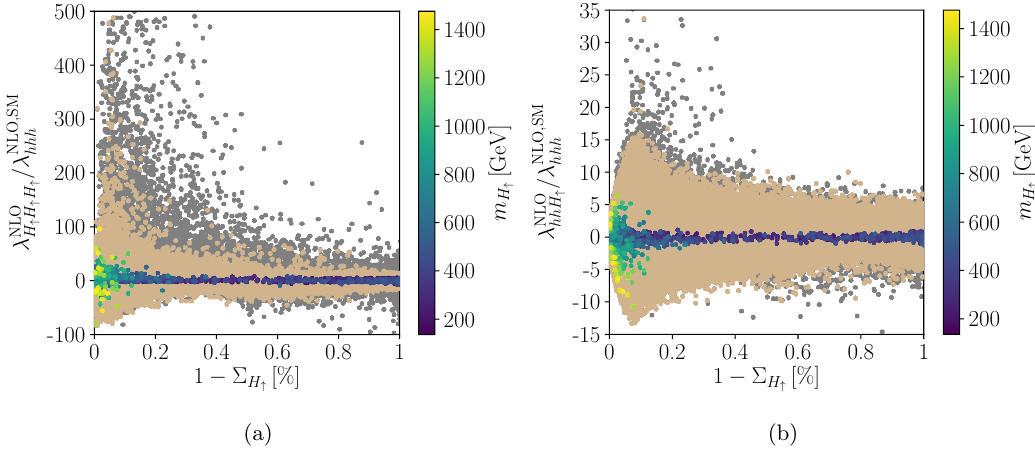
Figure 7 . N2HDM T1: Left: the NLO trilinear self-coupling between three heavy neutral Higgs bosons H " normalised to the SM reference value versus the doublet admixture of the heavy neutral Higgs boson (cid:6) H . Right: the NLO trilinear self-coupling between two SM-like Higgs bosons and " one heavy neutral Higgs boson H " normalised to the NLO SM reference value. The color scale show the mass value m H for those points that are compatible with an SFOEWPT. "